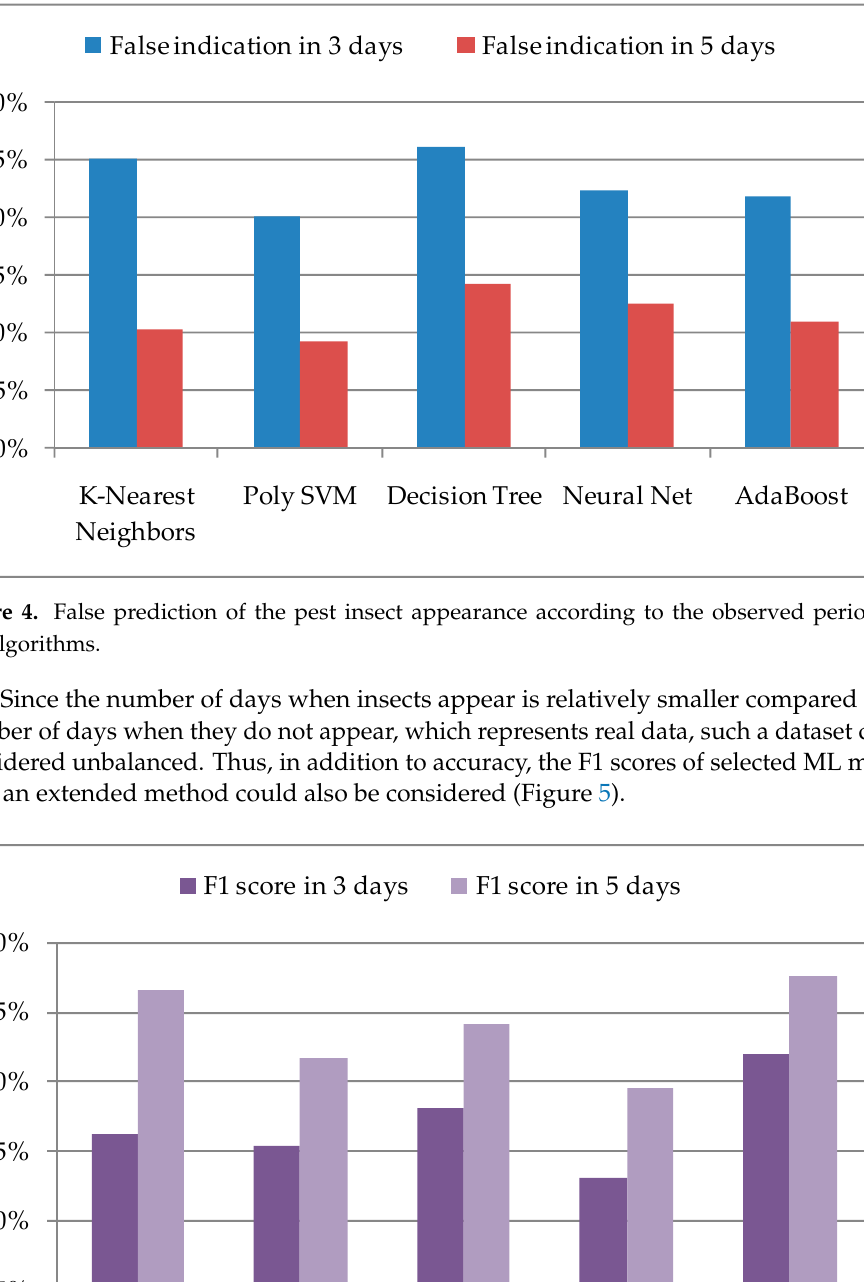
and AdaBoost algorithms generate the highest scores. The ML model with AdaBoost also has one of the smallest values of false detections; for AdaBoost, it is about 11% in the observed period of five